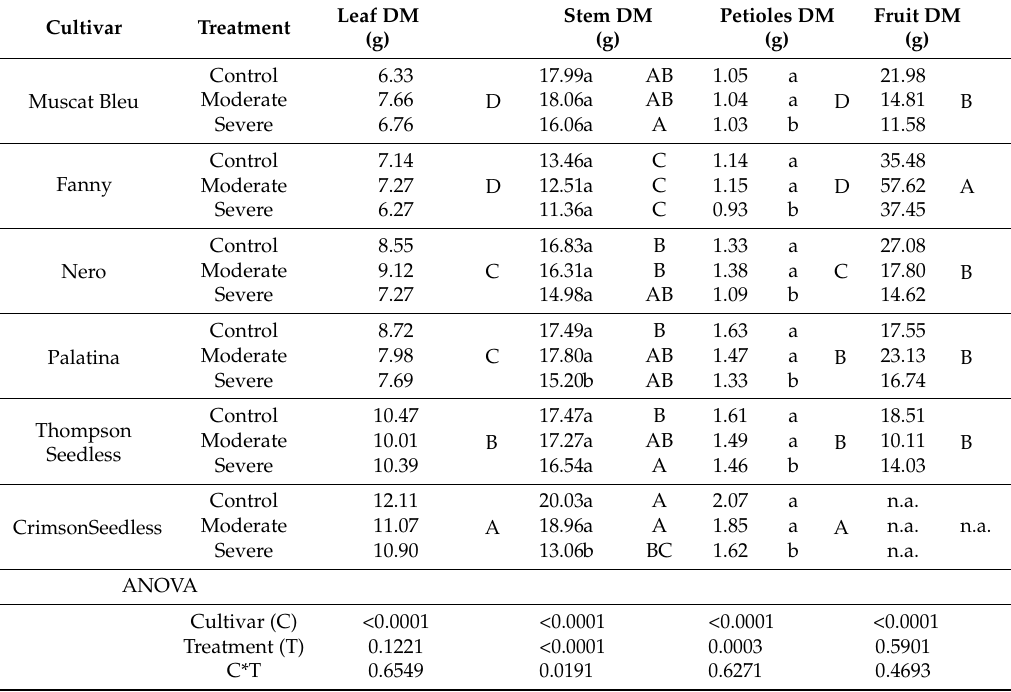
Table 4. Mean values of annual dry mass production of leaf, stem, petioles, and fruit of six table grape cultivars subjected to three water deficit